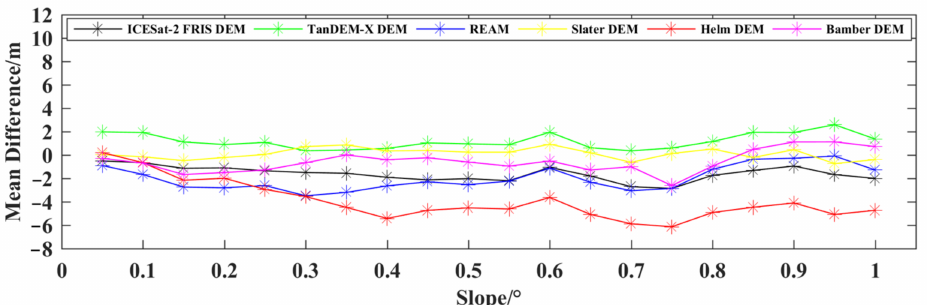
Figure 13. Mean differences between ICESat-2 FRIS DEM as well as the five Antarctic DEMs and OIB elevations. The horizontal coordinate is the slope of the surface from 0 ◦ to 1 ◦ with an interval of 0.05 ◦ .